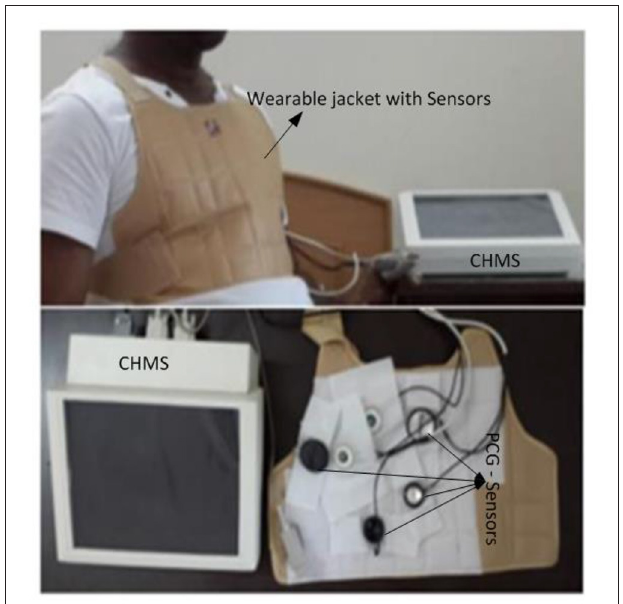
FIGURE 5 | Real-time experimental setup with proposed